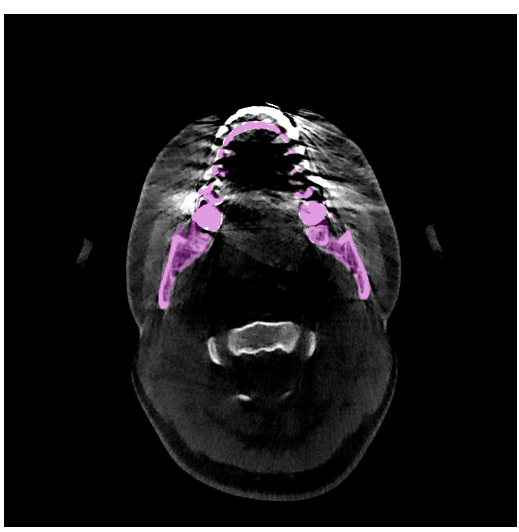
Figure 1. Example of manual annotation of the mandible in a CBCT image with strong metal